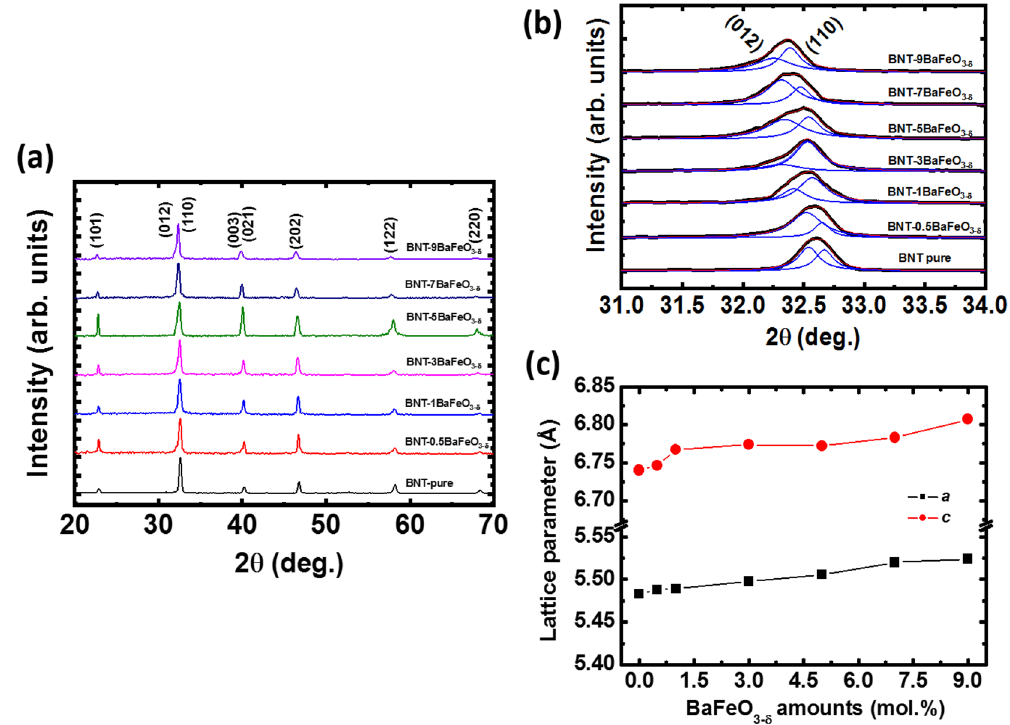
Figure 3. (a) X-ray diffraction pattern of BaFeO 3− δ solid solution into Na 0.5 Bi 0.5 TiO 3 with various concentrations within the 2θ range of 20° to 70°; (b) magnified X-ray diffraction within 2θ range of 31°–34° for comparing setline (012)/(110) peaks; and (c) dependence of the lattice parameters of pure Bi 0.5 Na 0.5 TiO 3 and BaFeO 3− δ - modified Bi 0.5 Na 0.5 TiO 3 samples on the amounts of BaFeO 3−δ solid